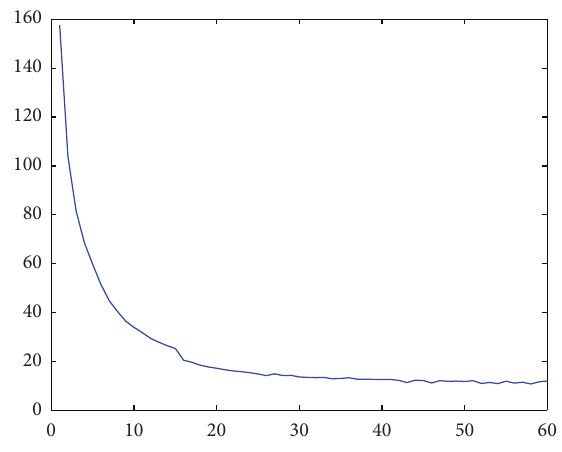
Figure 2: JC values change with category